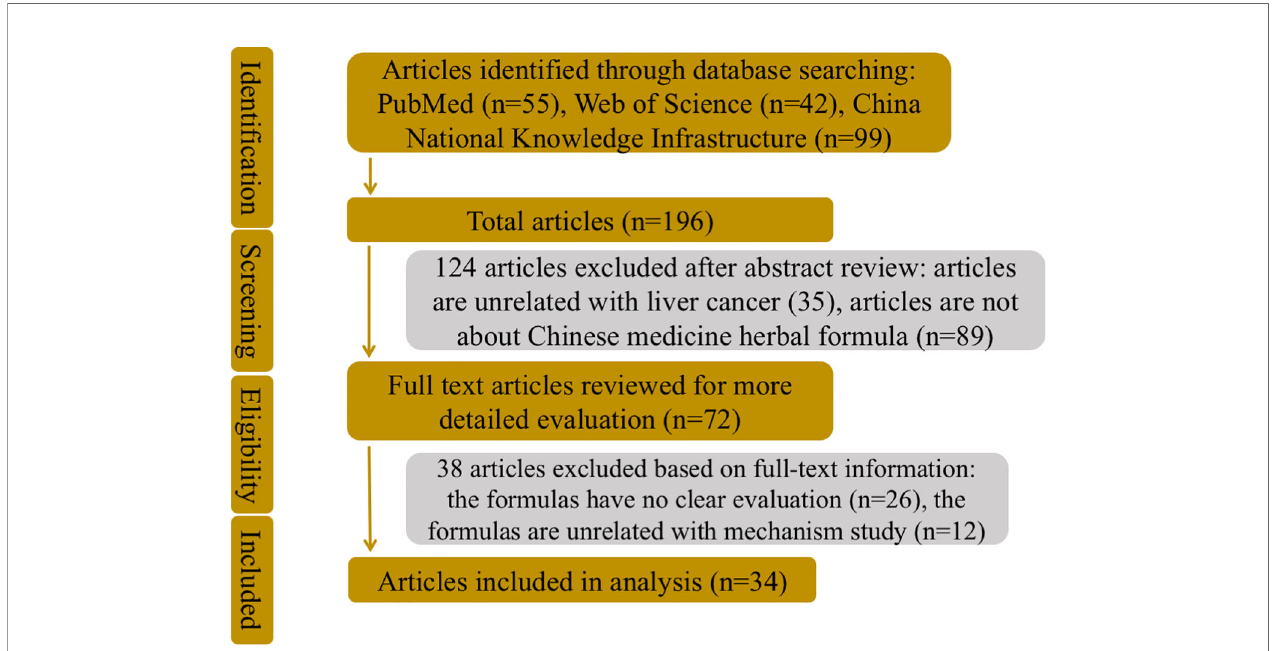
FIGURE 2 | The fl owchart of the literatures search strategy, inclusion and exclusion